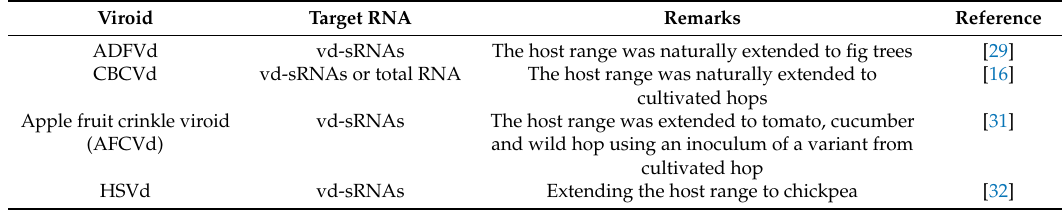
Table 2. Extending the host range of viroids by NGS.